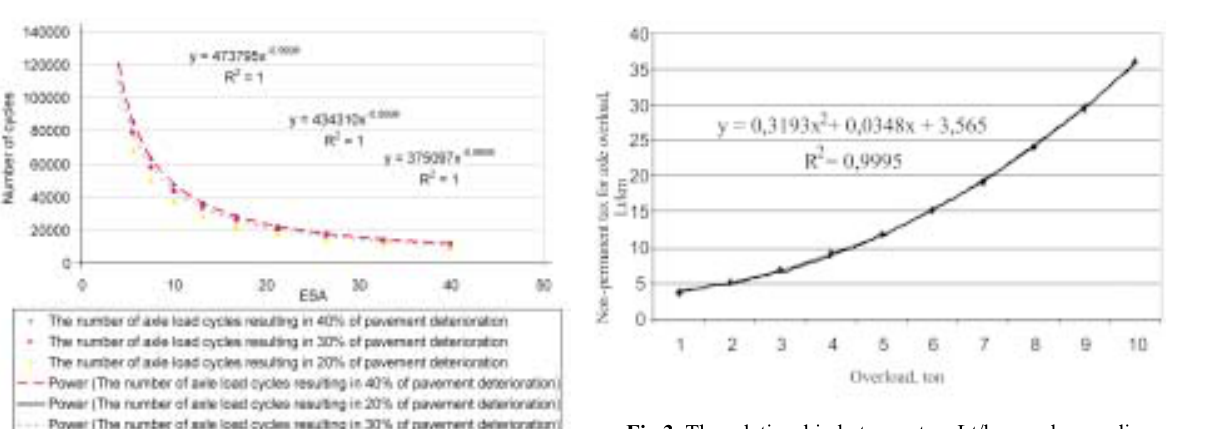
Fig 3. The relationship between tax, Lt/km, and exceeding of allowable load, ton